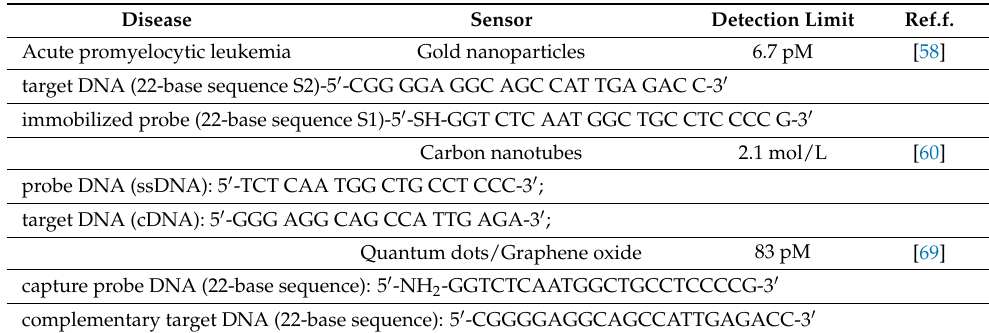
Table 1. Possible biosensors for PML/RAR α